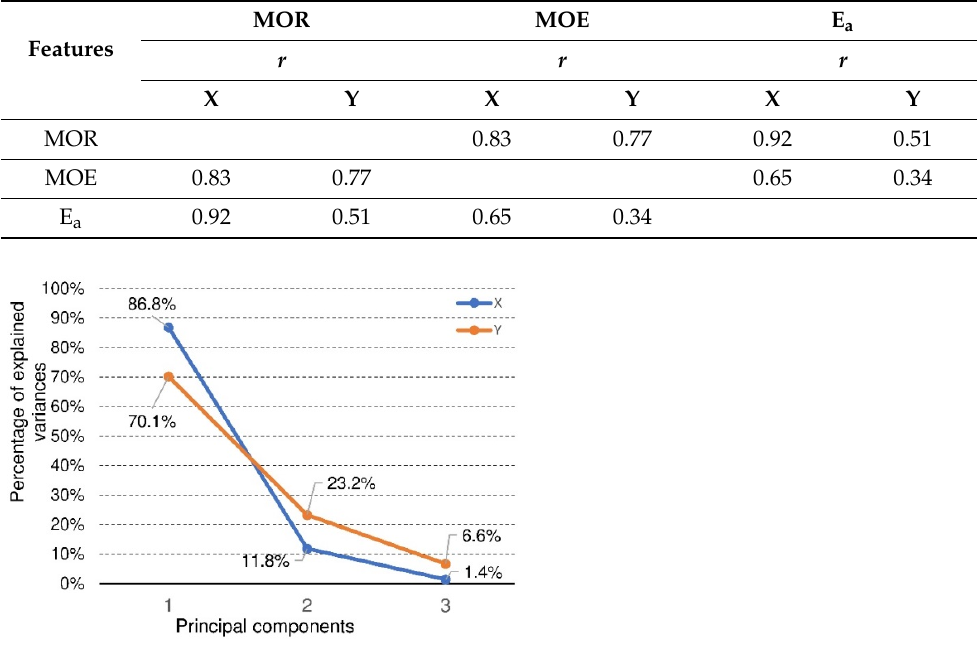
Figure 16. Principal components of feature connected with beams orthotropy in X and Y direction.